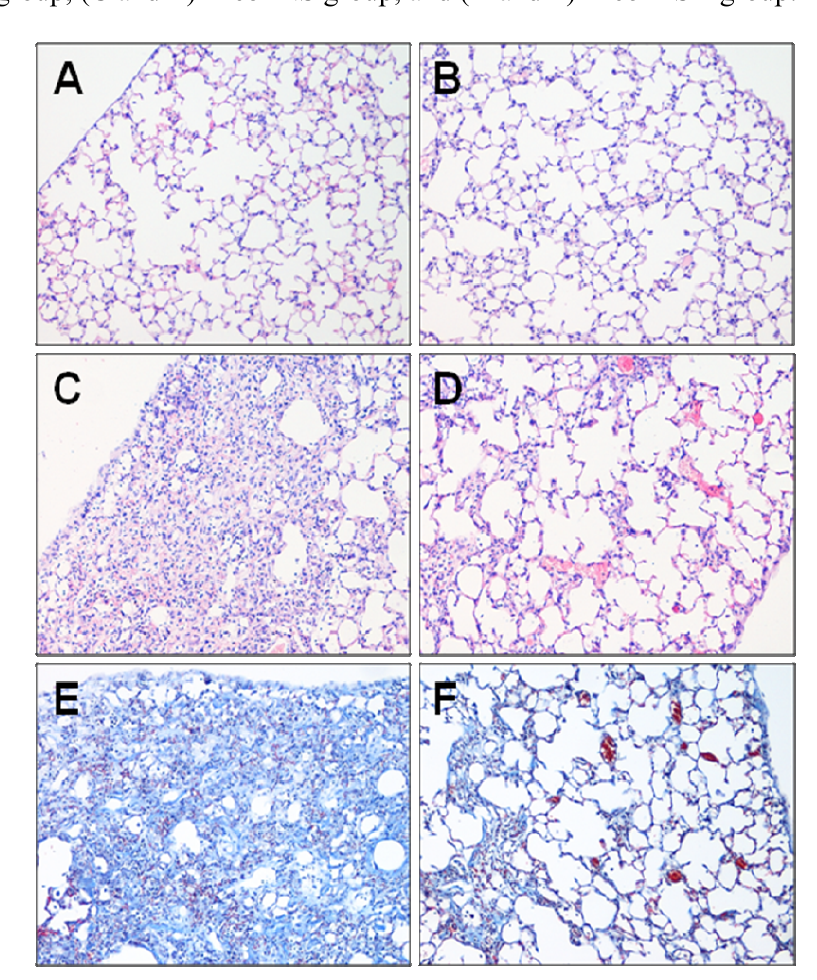
PBS+FSH group, (C and E) Bleo+NS group, and (D and F) Bleo+FSH